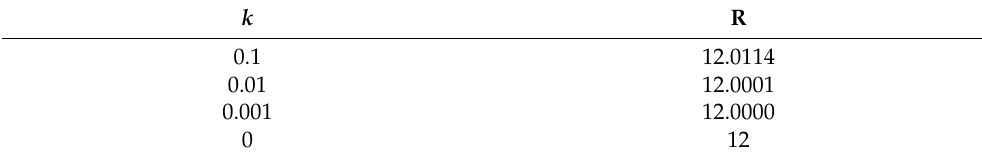
Table 1. Neutral stability values of R for small values of k for the Newtonian limit El →